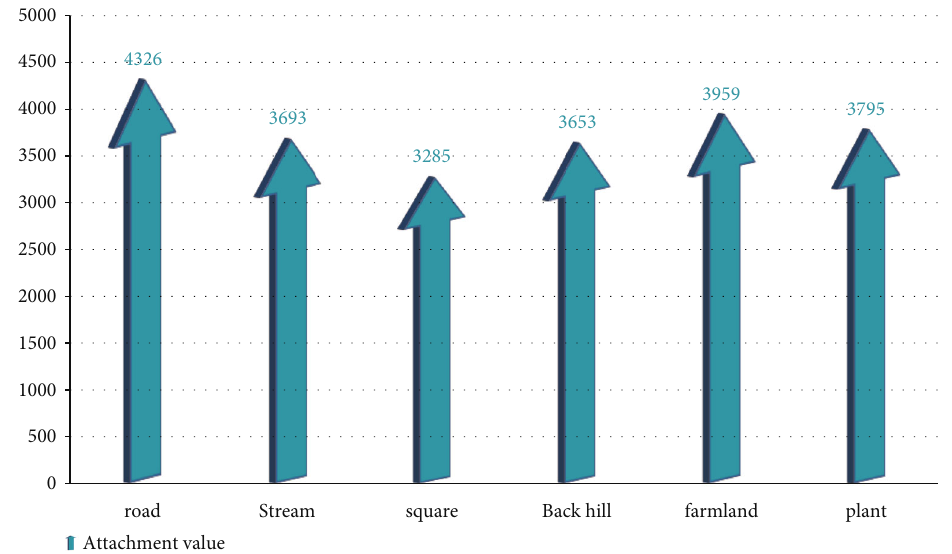
Figure 4: Types of public landscape